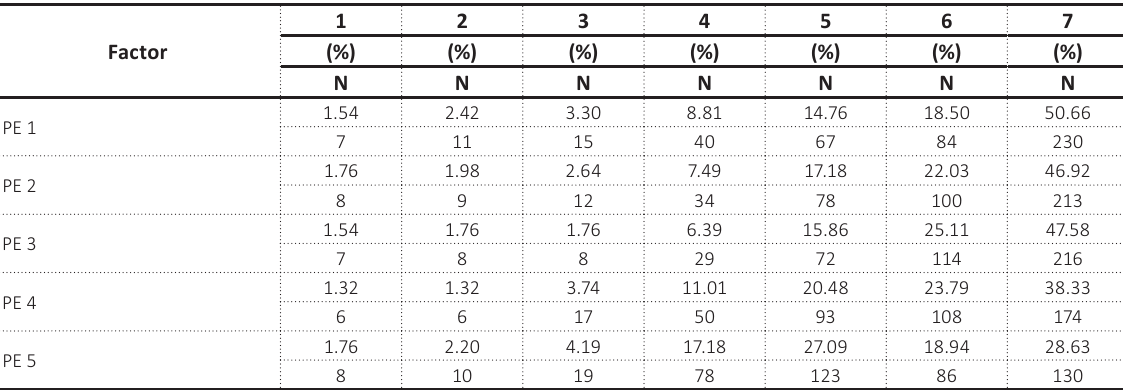
Source: Own processing.